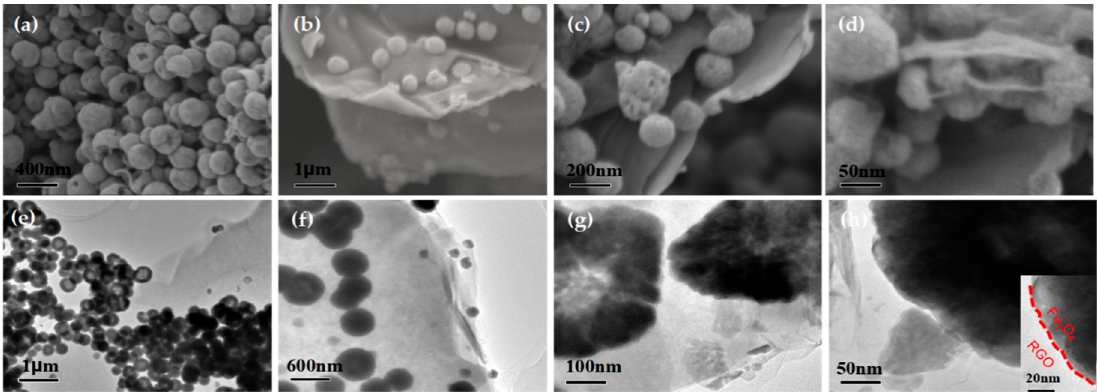
Figure 4. Scanning electron microscopy (SEM) image of hollow Fe 3 O 4 ( a ); hollow Fe 3 O 4 @RGO ( b – d ); and transmission electron microscopy (TEM) image of hollow Fe 3 O 4 @RGO ( e – h ).